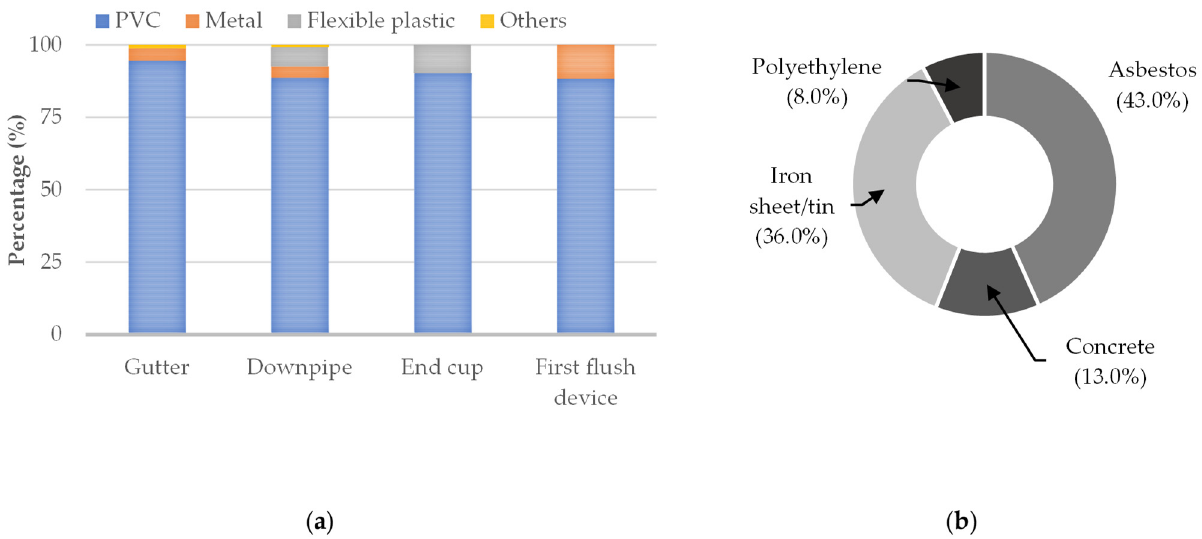
Figure 7. ( a ) Materials used for the different components of the RWH system; ( b ) nature of the roof catchment. The values in percentages indicate the proportion of households.